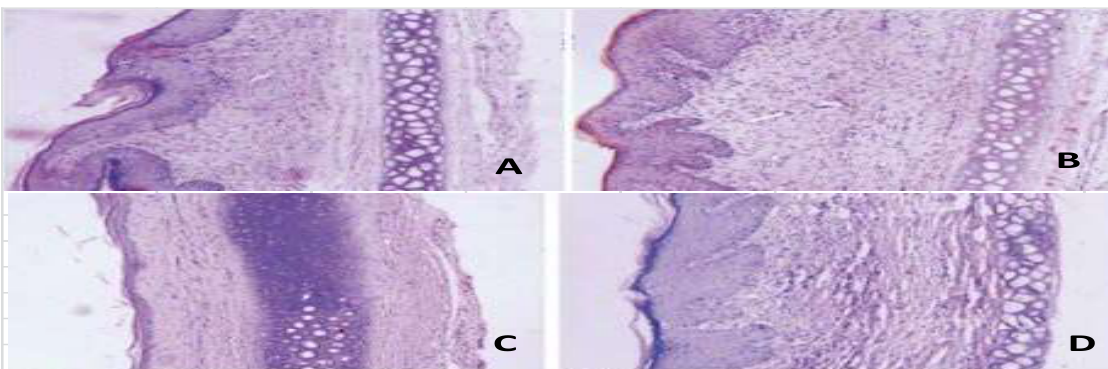
Figure4. Represent height of scar from perichondrium to skin surface(x4) A) Normal skin (110µm) B) induced hypertrophic scar tissue (700 µm), (C) treated hypertrophic scar of 0.1% TAC steroid gel (320µm), (D) treated induced hypertrophic scar of 0.5% Ritodrine gel (700 µm) *(10x, 4x): ordinary Hematoxylin and eosin